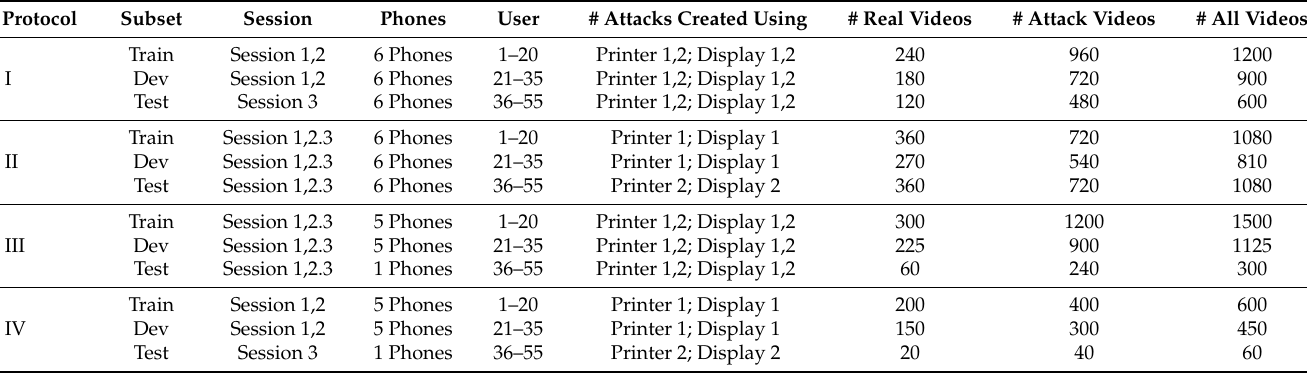
Table 1. OULU-NPU datasets